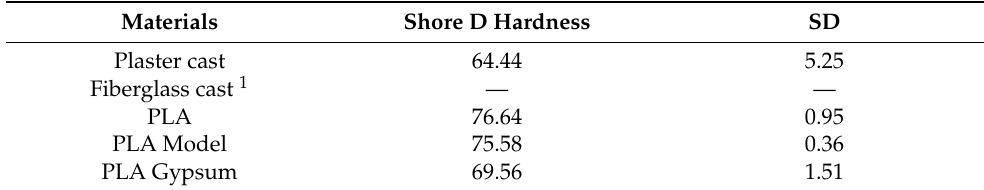
Table 2. Shore D hardness measure values.